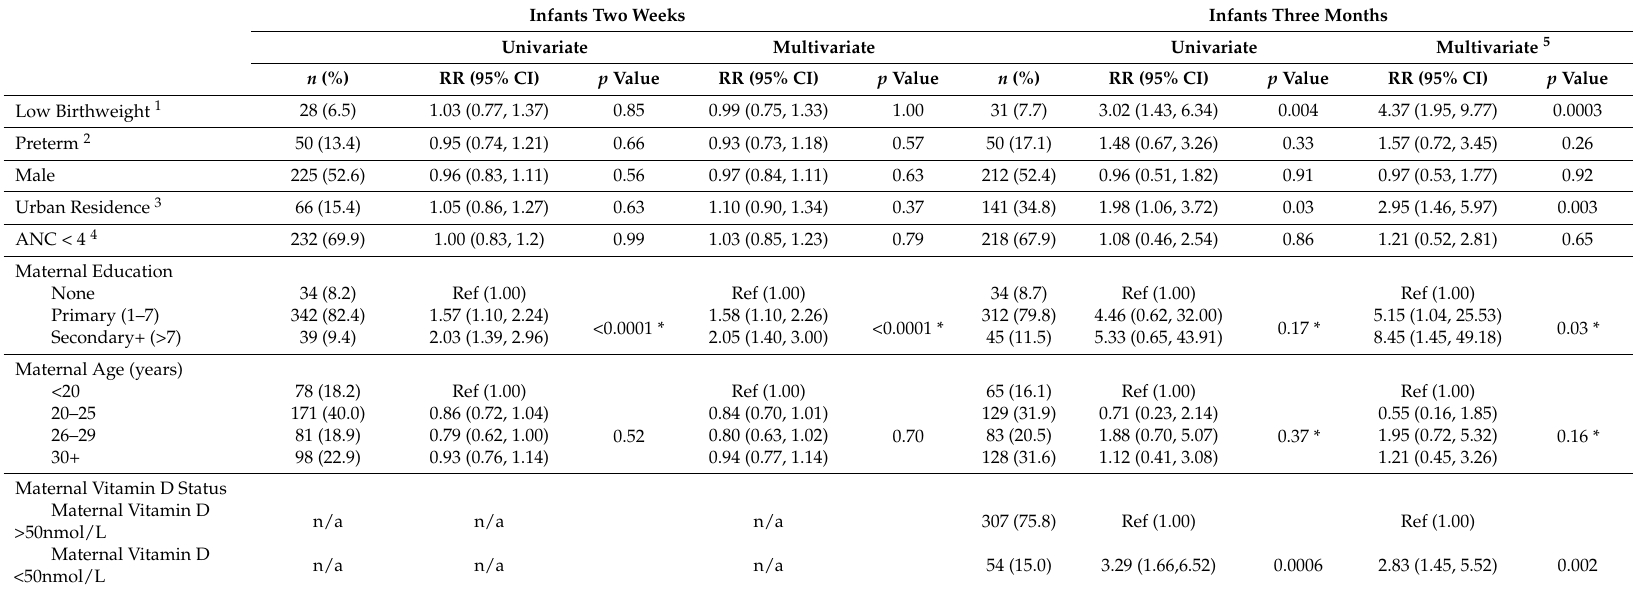
Table 4. Predictors for vitamin D deficiency (<50 nmol/L) for